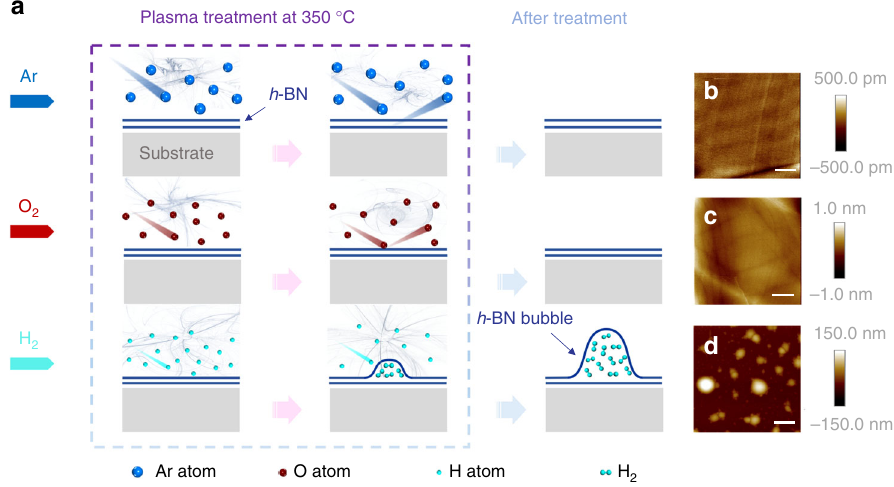
Fig. 1 Production of bubbles on h -BN fl akes via plasma treatment. a Schematic depicting the plasma treatment of h -BN fl akes in different atmospheres. All AFM height images of the h -BN fl akes were taken after plasma treatment in an atmosphere of b argon, c oxygen or d hydrogen. The h -BN fl akes appear to remain intact after the argon and oxygen plasma treatments, while obvious bubbles are observed on the h -BN surface after treatment with the H-plasma. All samples were obtained under similar conditions. Scale bars in ( b – d ) are 4 μ